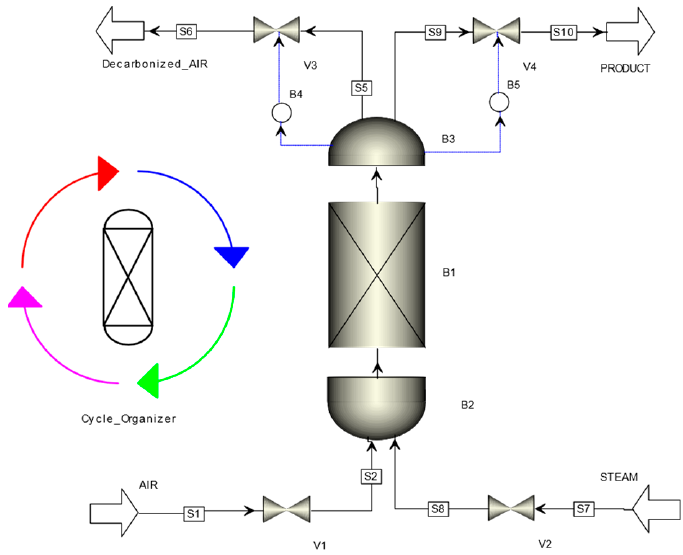
Figure 2. Process flowsheet for DAC in Aspen Adsorption.